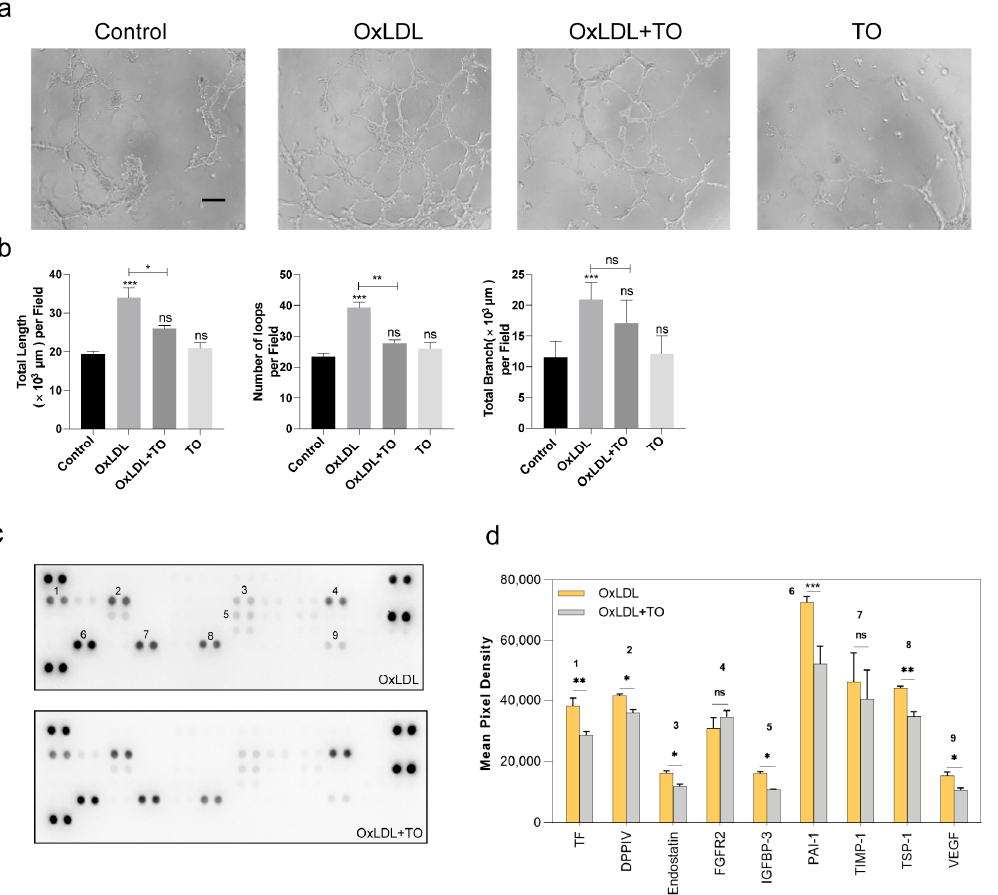
Figure 2. Effect of LXR agonist on OxLDL pretreatment to RPE cell. ( a ) RF/6A cell tube formation through RPE cell cytokines treatment. ( b ) The quantitative results of tube formation. Evaluation of tube formation by the number of loops, the total length, and branch length of tube in RF/6A cell. bars = 500 µ m. Values are expressed as means ± SEM, ns indicates p > 0.05, * p < 0.05, ** p < 0.01, *** p < 0.001 vs. control group ( c ) The Human Angiogenesis Array detects multiple analytes in cell culture lysates. ( d ) Histogram profiles of specific analytes are created by use of imagery software to quantify the average speckle pixel density from the array membrane. Values are expressed as means SEM, ns indicates p > 0.05, * p < 0.05, ** p < 0.01, *** p < 0.001 vs. OxLDL group, 1 indicates TF, 2 indicates DDPIV, 3 indicates Endostain, 4 indicates FGFR2, 5 indicates IGFBP-3, 6 indicates PAI-1, 7 indicates TIMP-1, 8 indicates TSP-1, 9 indicates